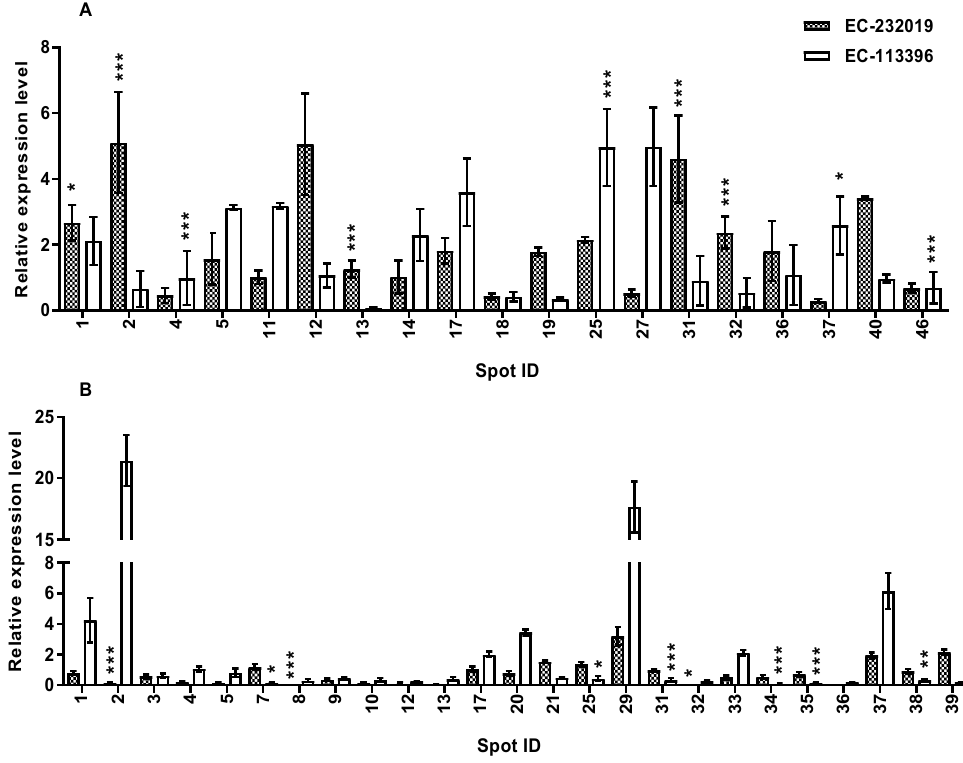
Figure 6. Relative transcript levels of genes encoding differentially abundant proteins ( A ) up-regulated and ( B ) down-regulated by more than two-fold at low (4 µM) P in soybean roots. Data correspond to mean±SE ( n =9). Spot ID corresponds to the protein spots in Supplemental Figure S3B,D. *, ** and *** denote significance at 0.05, 0.01 and 0.001 probability levels, respectively.